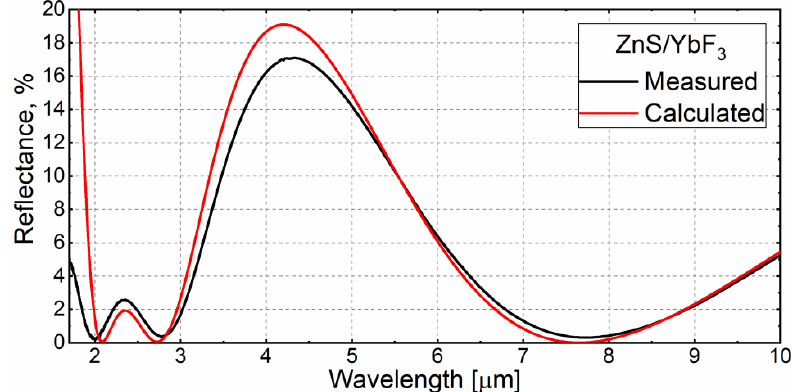
Figure 5. The calculated and measured reflection spectrum of the developed coating.